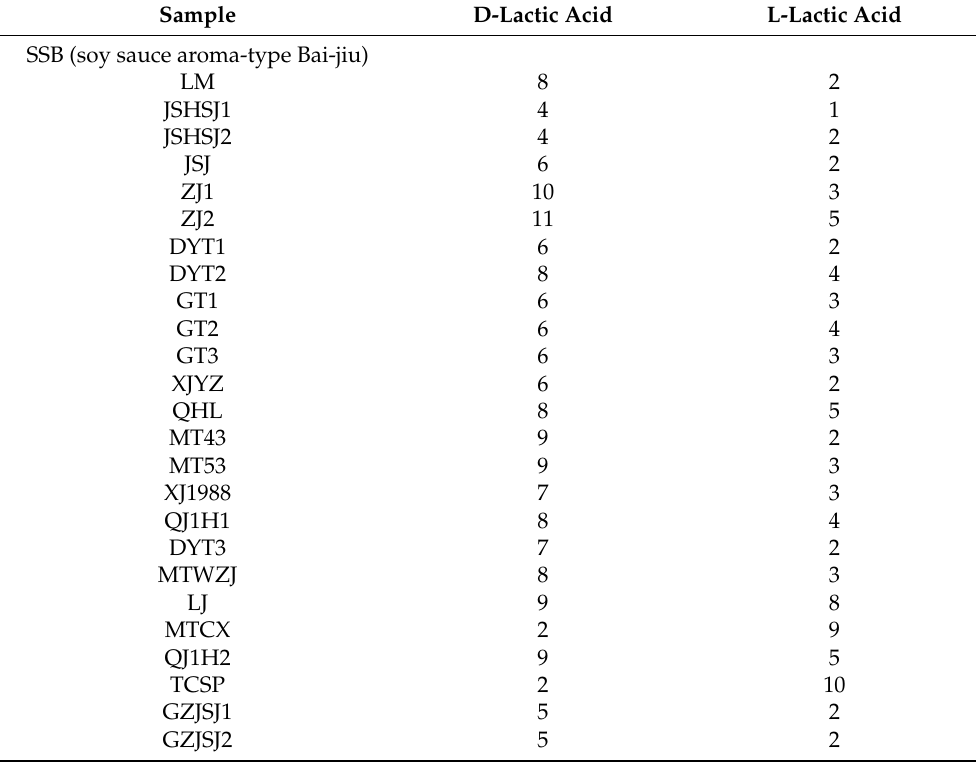
Table 5. TAVs of lactate enantiomers in the